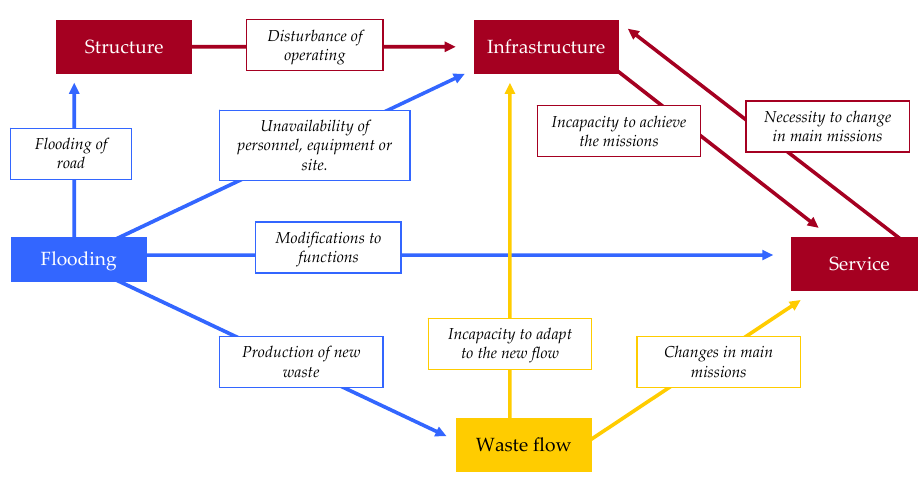
Figure 7 : The functional block diagram of « collection agent » 7 Fig. 7. The functional block diagram of a “collection agent”.